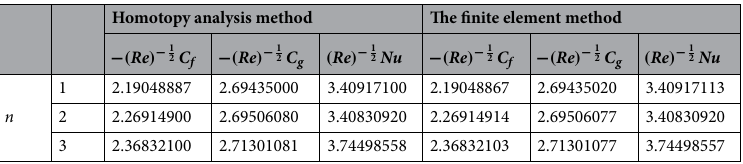
Table 3. The comparison of results for MoS 2 / SiO 2 -nanofluid using two methods (homotopy analysis method and the finite element method) when M = 0.001, (cid:31) E = , 0.3 h s = 0.3 and Sc = 0.3 = 0.004, φ = Pr = 204, h s = 1.3, φ 1 2